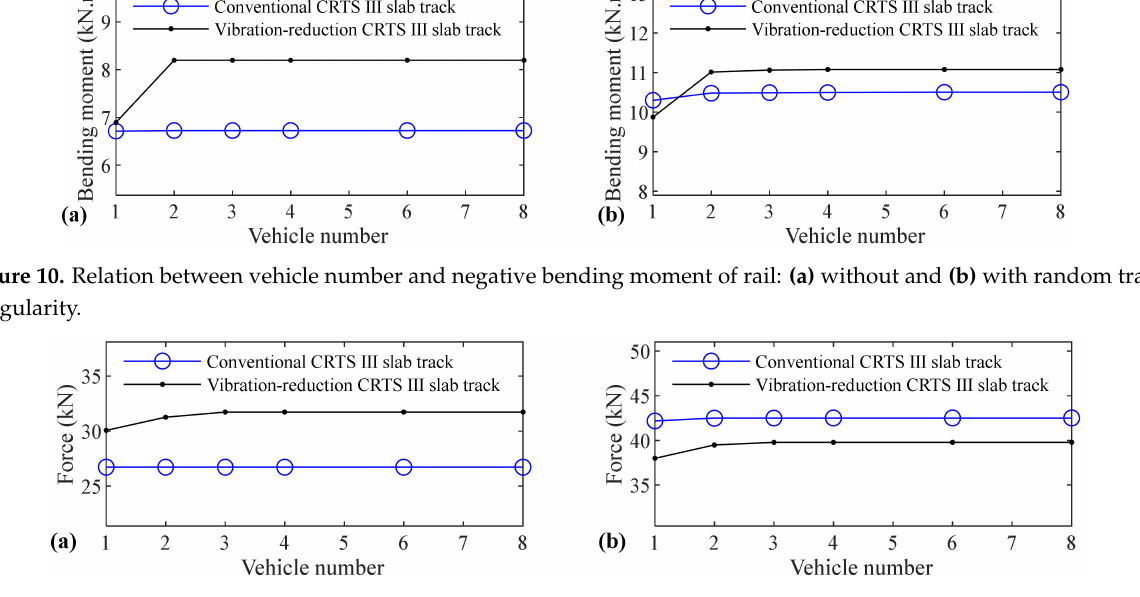
Figure 11. Relation between vehicle number and compressive force of fastener: ( a ) without and ( b ) with random track irregularity.